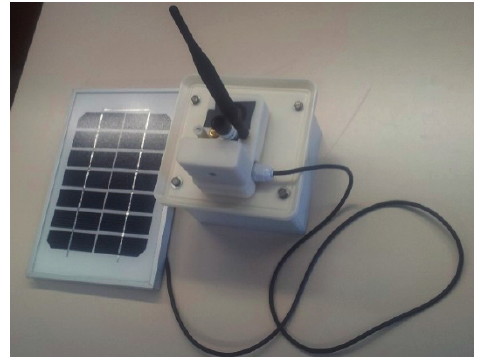
Figure 9. UIS EP